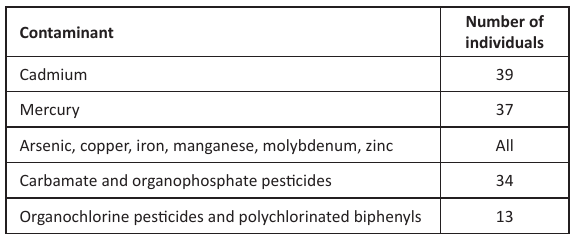
Table 4. Post-mortem results of 42 White-backed Vultures Adapted from (Oaks et al.